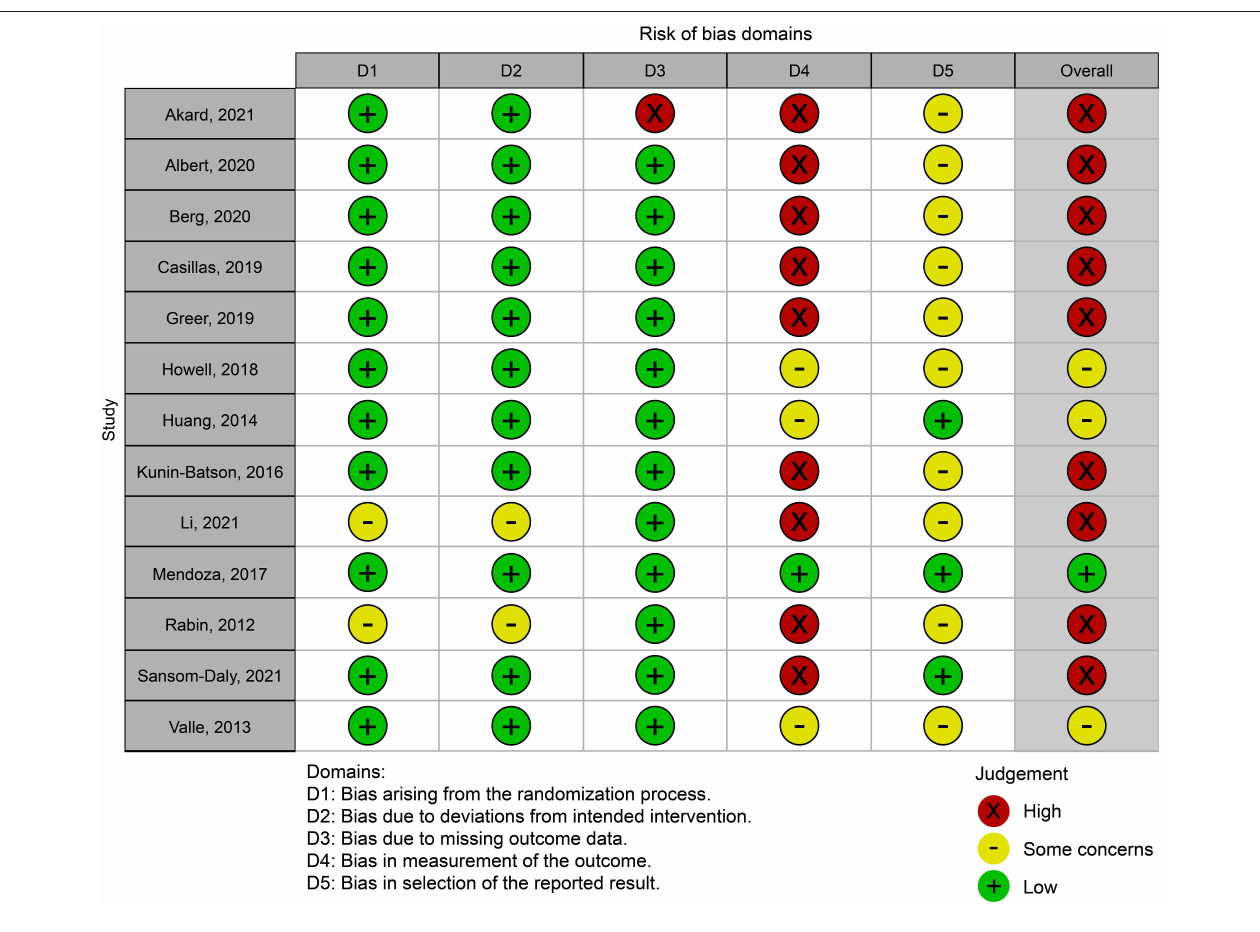
FIGURE 2 | Risk of bias